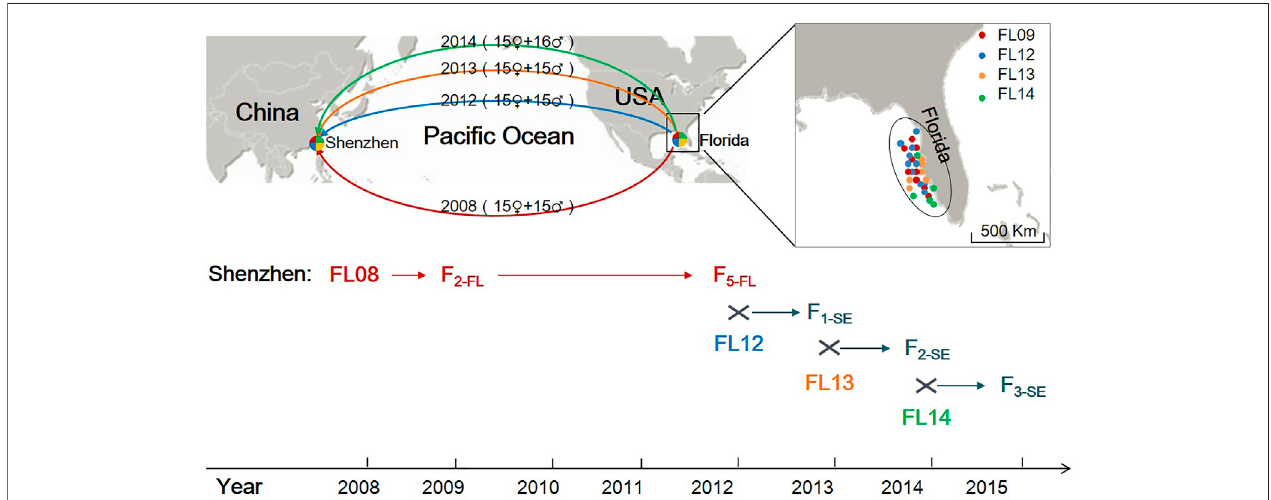
FIGURE1| Thesamplingsitesofwildlinedseahorses,asketchoftheintroductionfromtheUnitedStatestoChinaanda fl owchartofthehatcheryandasimulated stock enhancement in China. Red, blue, orange, and green lines indicate the introduction from Florida to Shenzhen in 2008, 2012, 2013, and 2014, respectively.